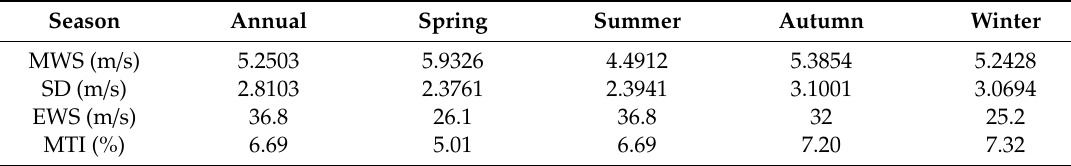
Table 4. Annual and seasonal parameters of observed wind